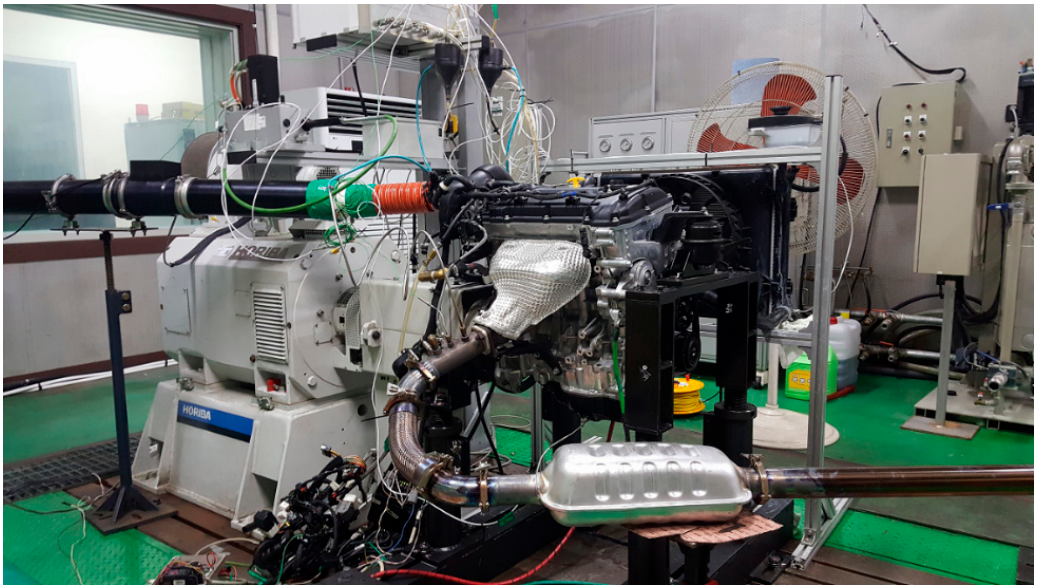
the radiator, and to control the coolant temperature and flow rate supplied to the radiator. chamber. It is configured to control the external temperature and amount of air blown to the front of